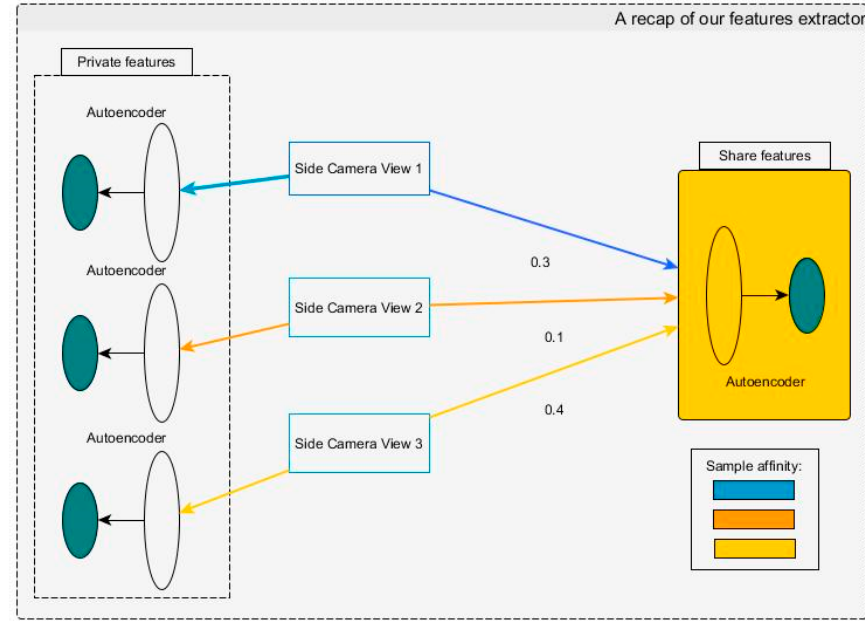
Figure 2. The figure shows a recap of our features